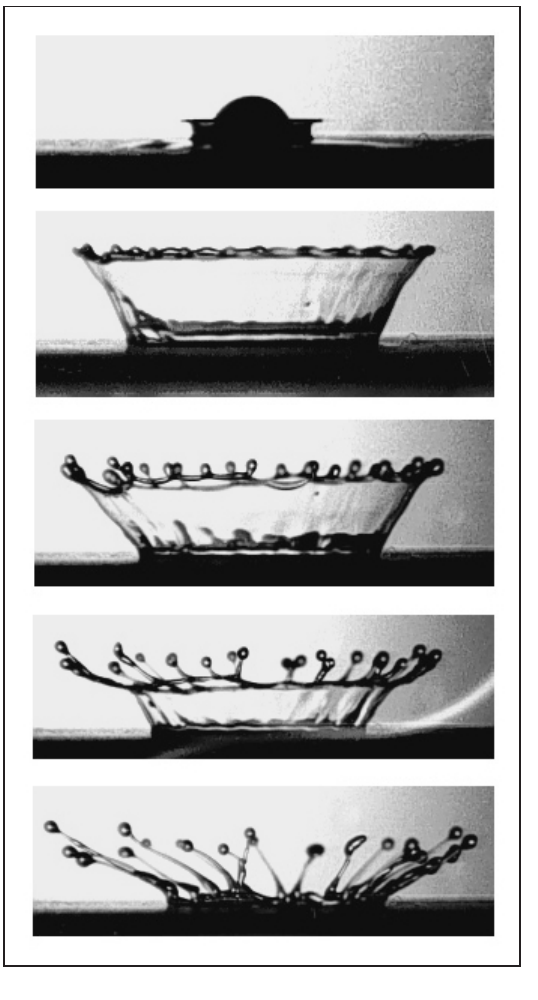
Figure 10: Impact of a drop on the thin film formed by the deposi- tion of the previous drop with a fixed and known sur- face roughness on an alu- minium surface (Fluid: